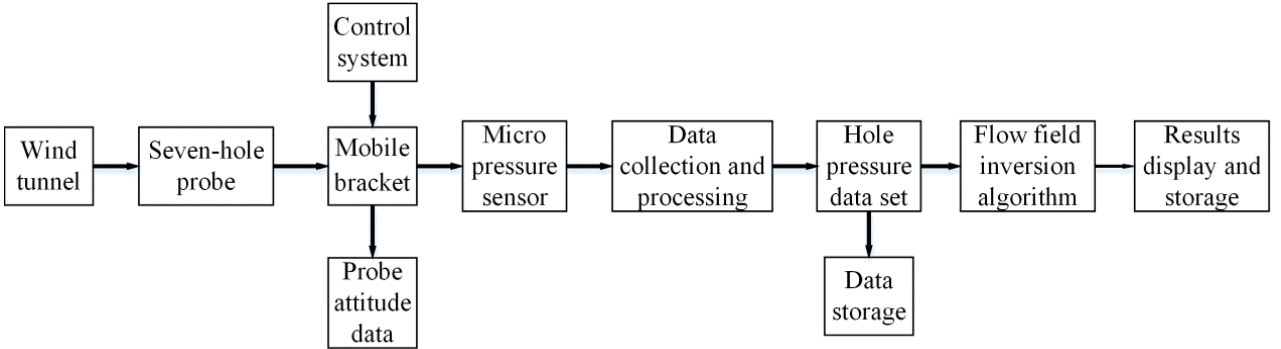
Figure 1. Overall design of the wind tunnel test system.